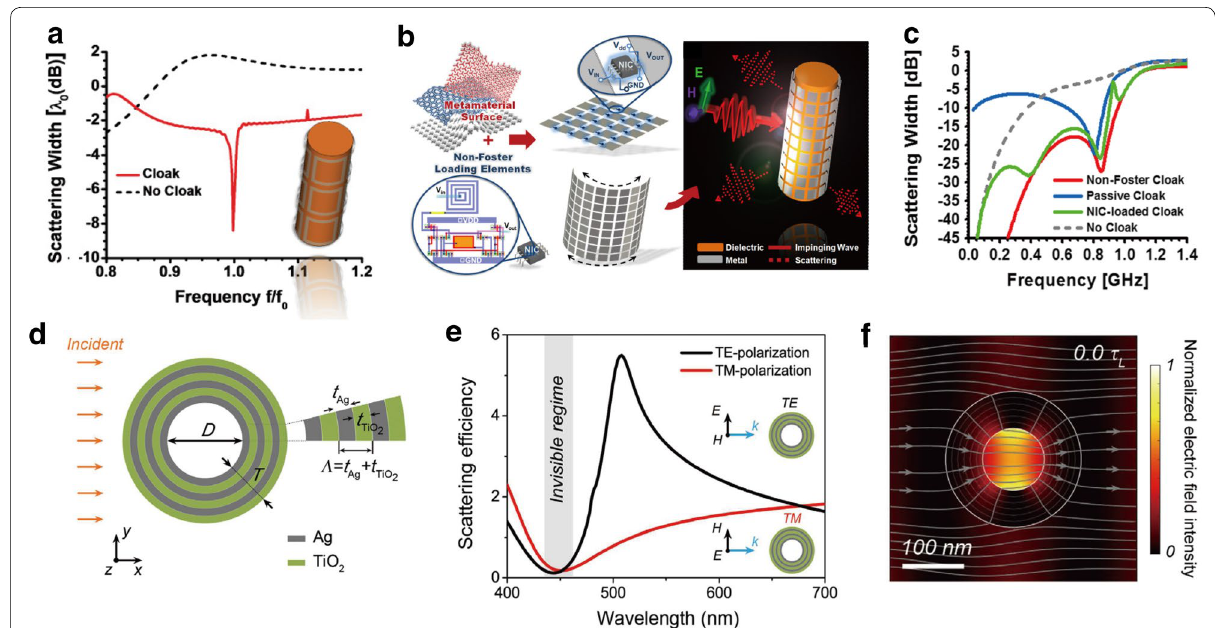
Fig. 3 Subwavelength cylindrical metasurface and metamaterial shell structures for invisibility cloaking. a Scattering width spectra (TM‑polarized light) of an infinitely long dielectric cylinder with (red solid line) and without (black dashed line) a metasurface mantle cloak. Inset: schematic illus‑ tration of the metasurface mantle cloaked device. The dielectric core has an electric permittivity of 10 and the diameter of λ /4, where λ is the invis‑ ibility wavelength. The metasurface comprises an array of square metallic rings with a thickness of λ /400. b Concept of a broadband metasurface mantle cloak on an infinite dielectric cylinder featuring an array of ultrathin curved metal patches loaded with non‑Foster elements. c Normalized scattering width spectra of a dielectric core covered with various metasurface mantle cloaks. d Schematic illustration of a coaxial metal/dielectric multilayered metamaterial nanotube. The nanotube has an air core (diameter D ) and a metamaterial shell (thickness T ) comprising multiple lay‑ = = ers of alternating Ag/TiO 2 films. e Scattering efficiency spectra of a layered nanotube structure with a core diameter of 100 nm and a shell thickness of 60 nm for TE‑ (black line, top inset) and TM‑ (red line, bottom inset) polarized light. The thicknesses of both individual Ag and TiO 2 layers are set to 10 nm. The invisible region is indicated by a shaded gray area. f Snapshot of the normalized electric field intensity distribution and time‑averaged Poynting vector power flows (gray lines and arrows) near the metal/dielectric layered nanotube at the invisible wavelength of ~ 450 nm ( a is adapted from [28], b , c are adapted from [30], and d – f are adapted from